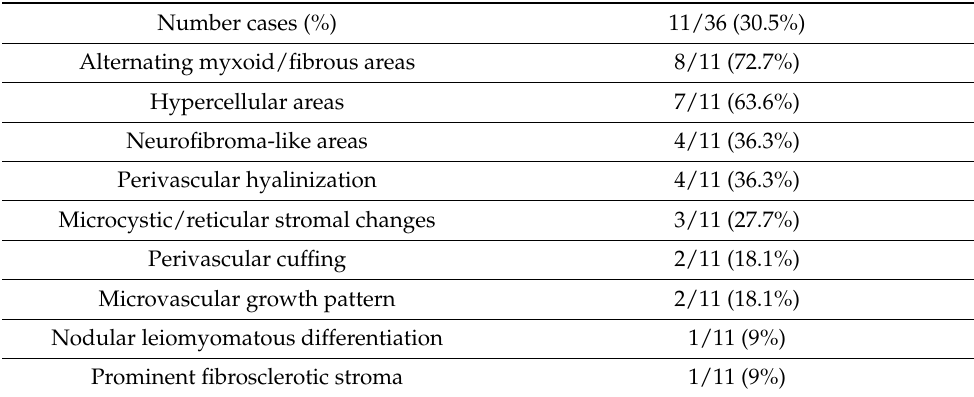
Table 1. Primary DAMS with uncommon morphological